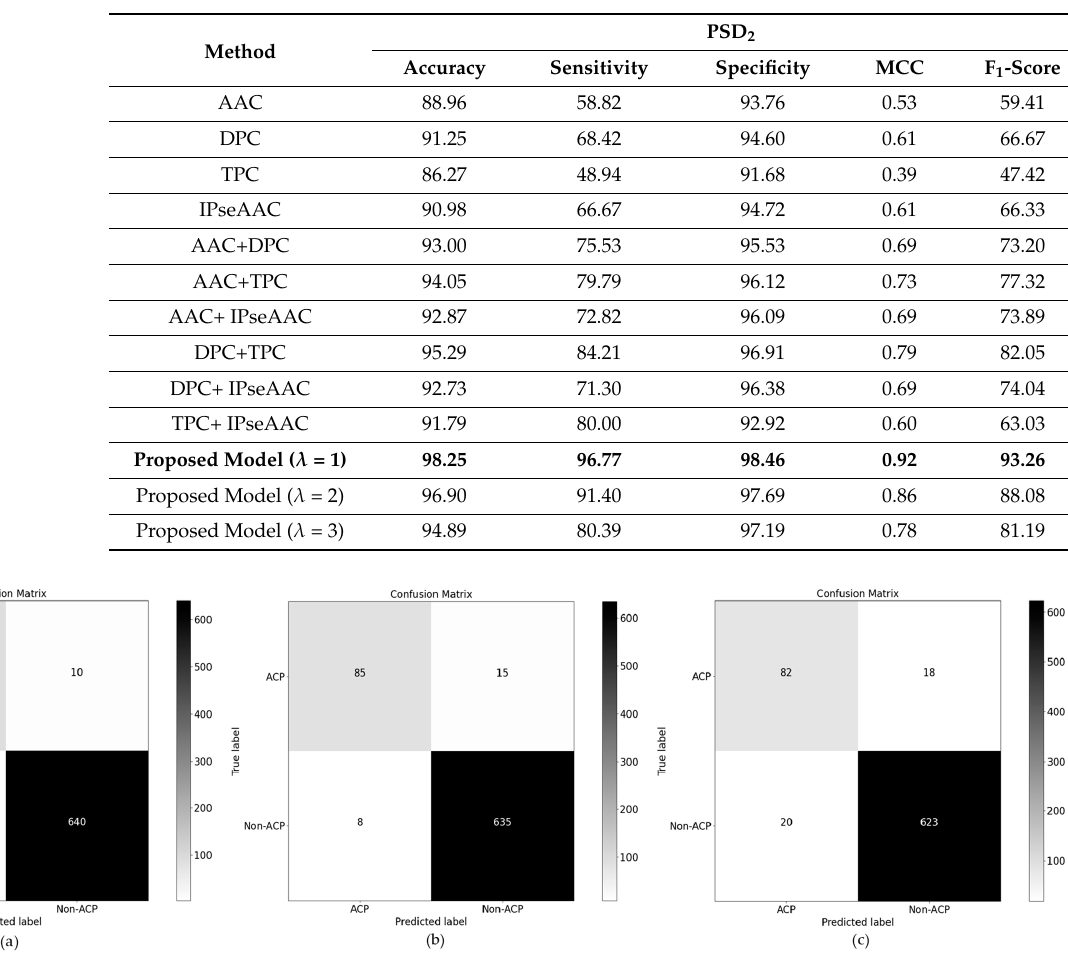
Figure 4. Performance evaluation of the proposed model over testing data of independent. Addition of physicochemical properties using the concept of ( a ) ( λ = 1); ( b ) ( λ = 1); and ( c ) ( λ =